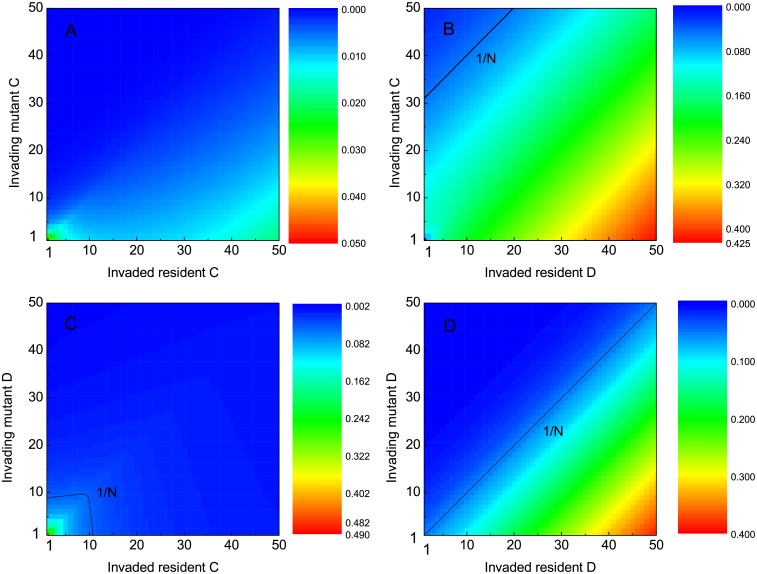
Pairwise invasion plots.Transition rate means the probability that the population moves from an invaded state to an invading state. The capital letter, C or D, along the Y-axis, denotes the mutant’s behavioral strategy, while the one along the X-axis denotes the residents’ behavioral strategy. The coordinate value denotes the number of potentially expressible phenotypes that individuals are endowed with. Parameters: N = 20, b = 1, c = 0.3, β = 0.1, θ = 0.1.